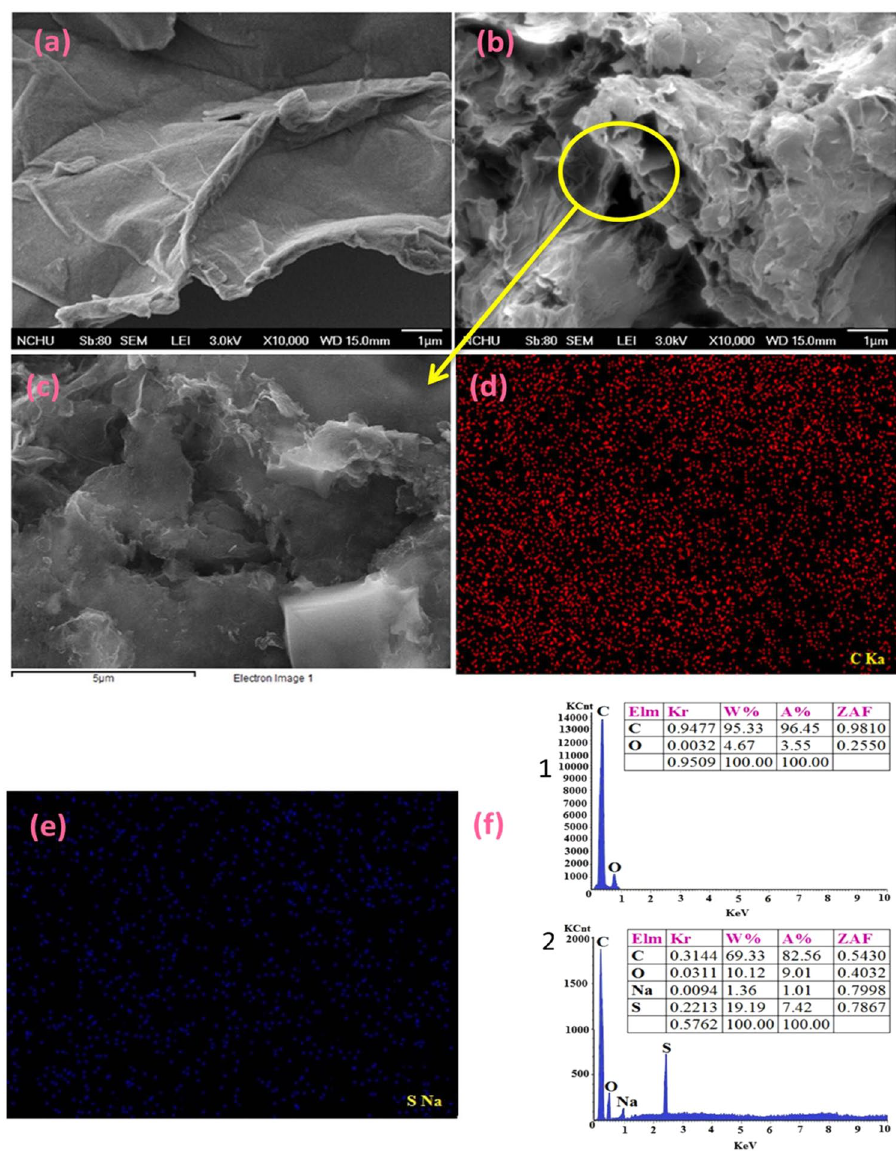
Figure 5. SEM images of ( a ) Graphite oxide, ( b ) synthesized sulfonated graphene oxide, ( c ) shows the SEM image of a huge area of dispersed powder of rGOPhSO 3 H on the silicon wafer for elemental analysis. ( d ) and ( e ) denote the resultant EDS elemental mapping of C and S of the region which shown in ( e ). (f 1 and f 2) displays the EDS elemental analysis of graphite oxide and sulfonated graphene